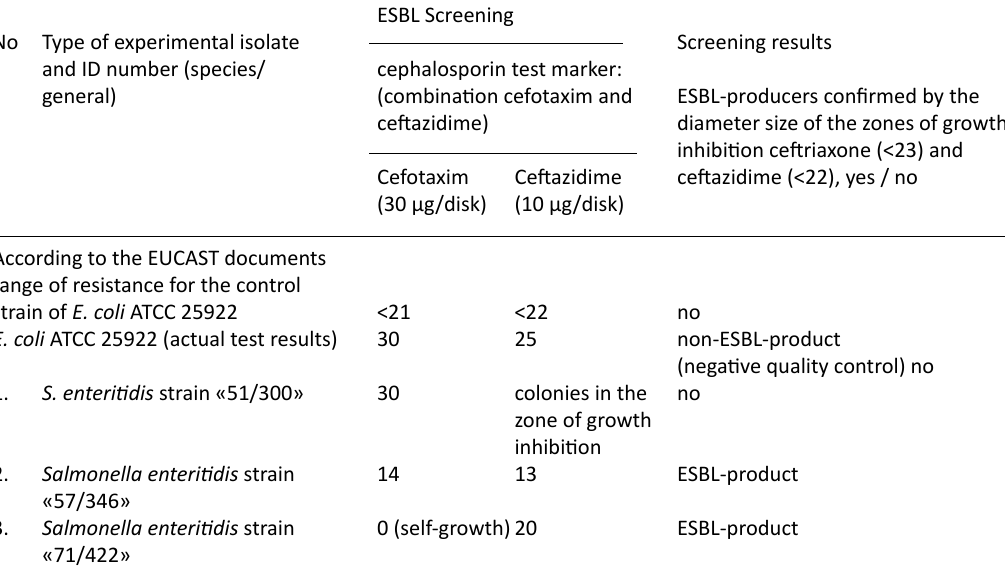
Table 4. Screening for ESBL-products in S. enteritidis isolates with cephalosporin markers ESBL